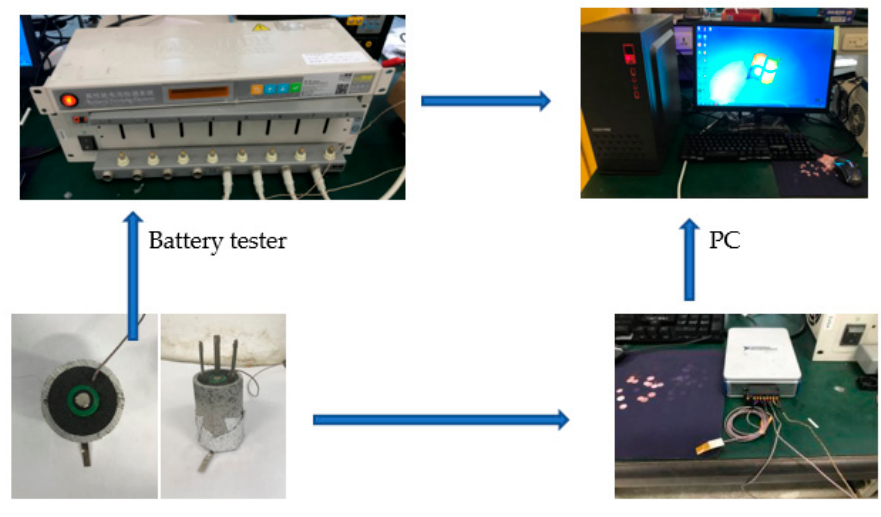
Figure 2. Schematic diagram of the experiment. Table 3. Design of charging and discharging experimental conditions.